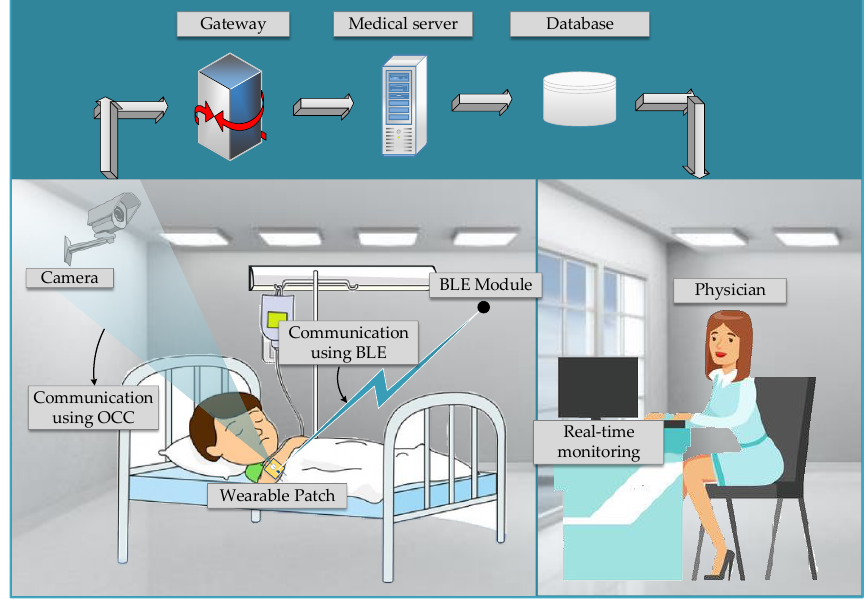
Figure 2. Topology of the proposed health monitoring